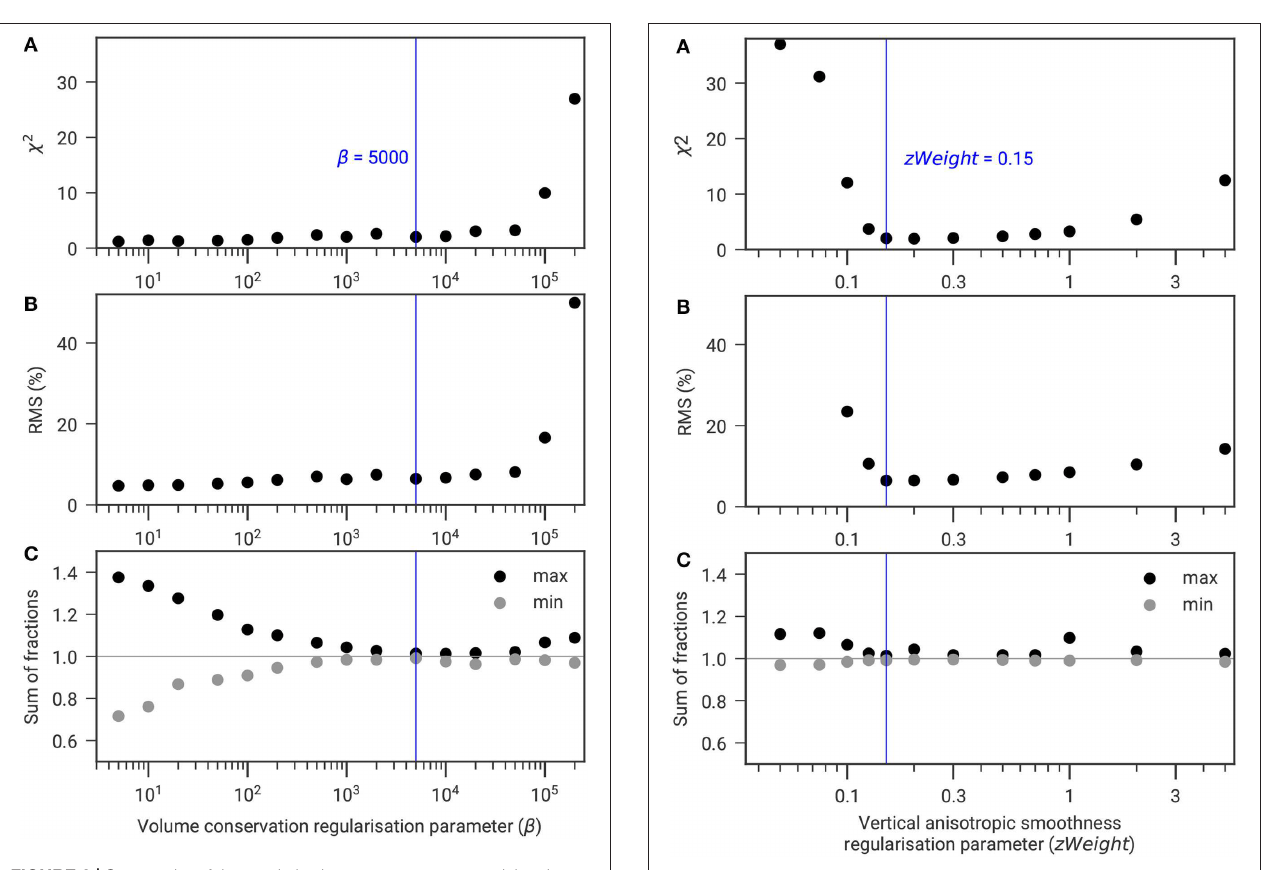
model G diverges from the three others at depth. Only model G two boreholes, e.g., at 7 m depth, where f r ∼ 0.7 and f i ∼ 0.25 are found for DOL1 (bedrock), while f r ∼ 0.3 and f i ∼ 0.7